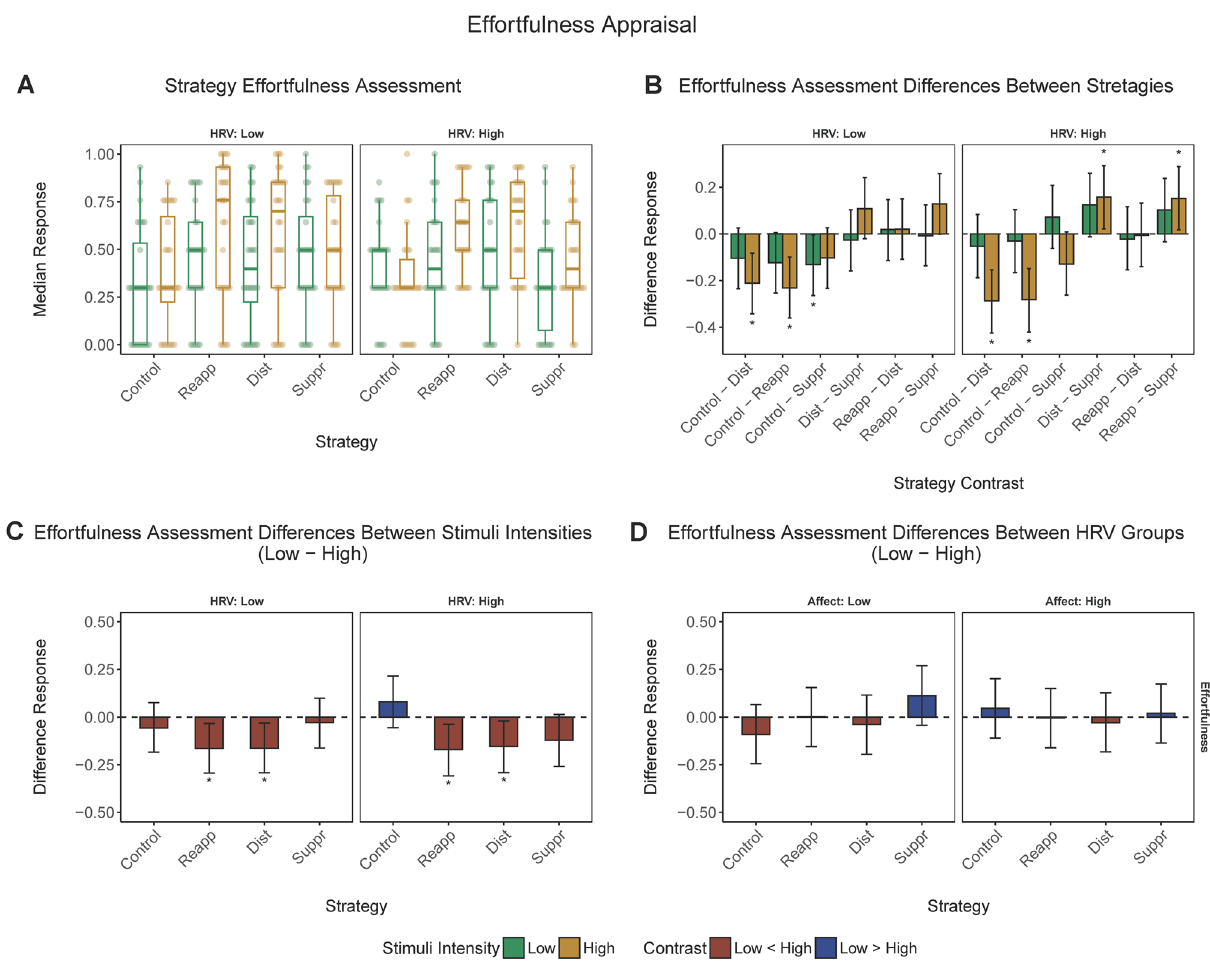
Figure 5. Perceived effortfulness . ( a ) Perceived effortfulness scores (median) corresponding to low or high negativity stimuli in different experimental conditions and low or high baseline HRV groups. ( b ) Pairwise contrasts of the Perceived effortfulness between emotional regulation conditions corresponding to low or high negativity stimuli in the low or high HRV group. ( c ) Contrasts of the Perceived effortfulness between low and high negativity stimuli across emotional regulation conditions in the low or high HRV group. ( d ) Contrasts of the Perceived effortfulness between low versus high baseline HRV groups. Behavioral responses have been rescaled to a range between 0 and 1. Error bars represent 95% CI of the corresponding estimate. *, significant